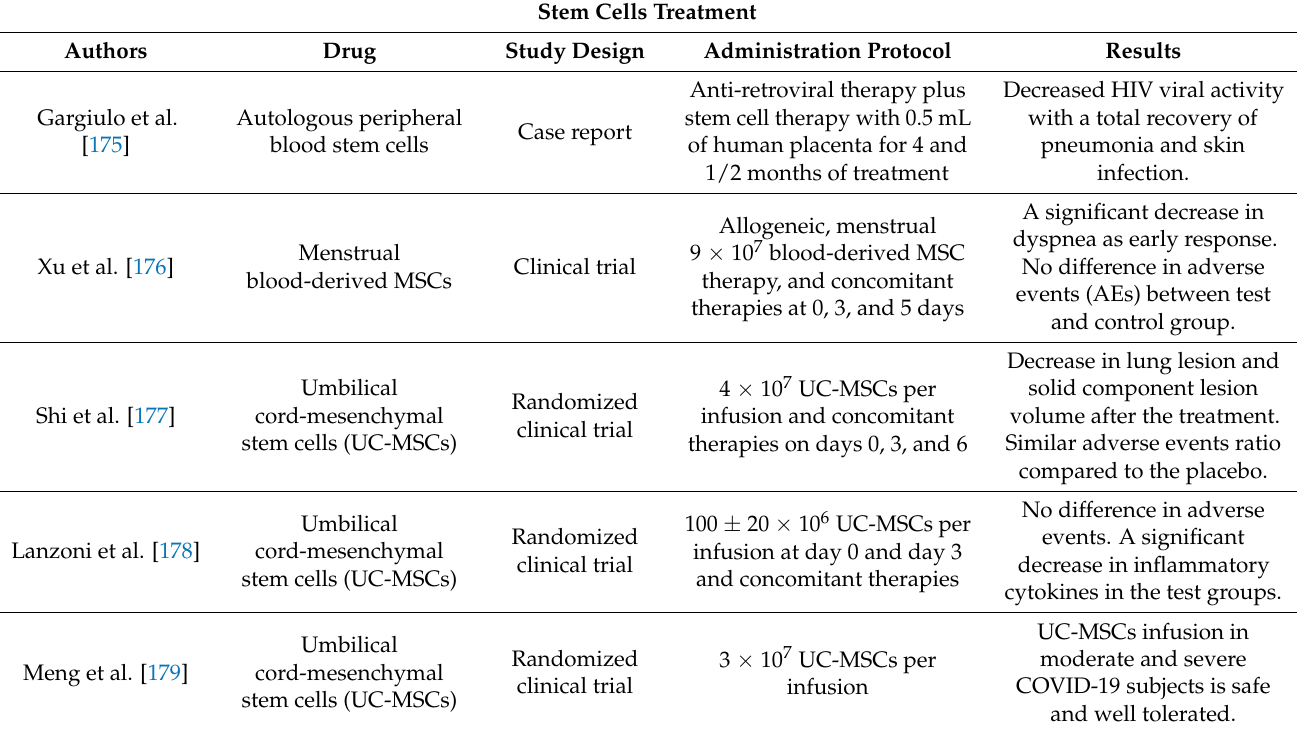
Table 8. Summary of the in vivo studies included about stem cells treatments for viral infections. Stem Cells